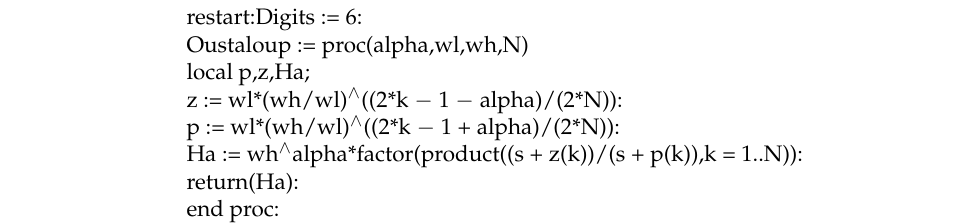
Table 6. Oustaloup’s approximation coded in Maple 18 environment.